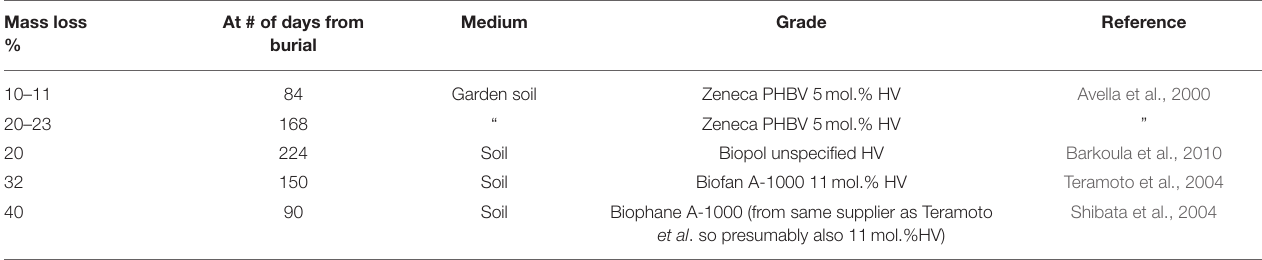
TABLE 1 | Mass loss data for neat PHBV reported in various